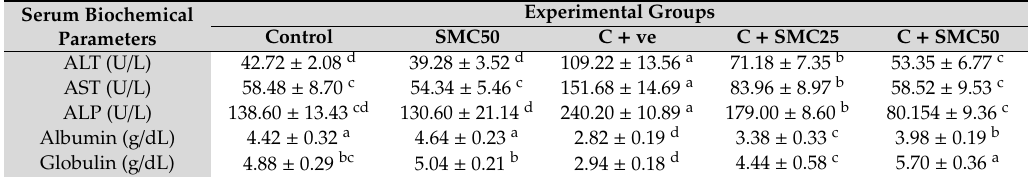
Figure 2. Serum level of amyloid P ( A ), Tumor Necrosis factor (TNF- α , ( B )), Interleukin 6 (IL-6, ( C )), and Interferon (IFN- γ , ( D )) after two weeks of s-Methylcysteine (SMC) treatment in C. parvum- infected mice. Control (received saline, orally); SMC50 (treated with s-Methylcysteine, 50 mg / kg, orally); C + ve (infected with 10 4 C. parvum oocysts); C + SMC25 (infected and treated with s-Methylcysteine, 25 mg / kg, orally); C + SMC50 (infected and treated with s-Methylcysteine, 50 mg / kg, orally). Data were expressed as mean ± S.D. Each bar carrying di ff erent letters (a, b, c, d) is significantly di ff erent ( p < 0.05). Table 2. Serum liver biomarkers following s-Methylcysteine treatment in C. parvum -infected mice. Experimental GroupsSerum